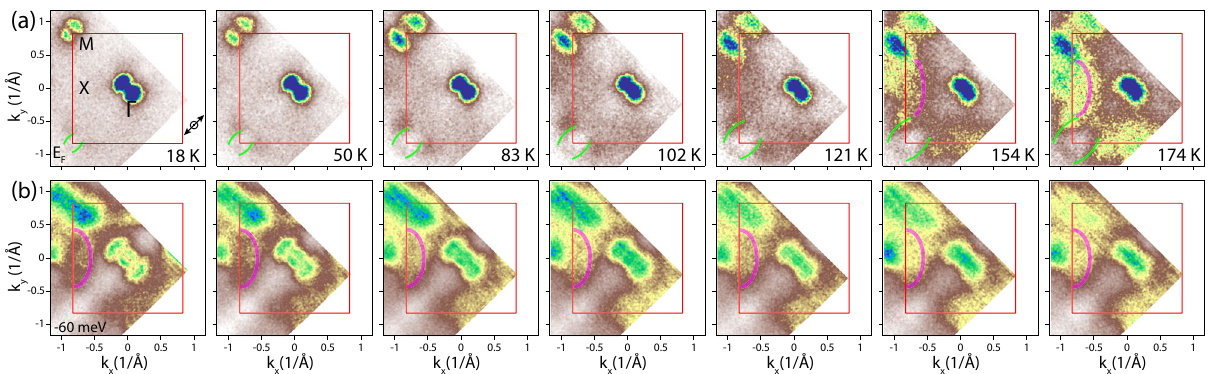
Fig. 2 Fermi surface evolution with temperature for FTS44. a Measured Fermi surfaces as temperature is varied between 18 K and 174 K. b Simultaneously measured constant energy contours at − 60 meV showing no change as a function of temperature. Polarization is as marked in the left- most panel of ( a ) indicating an in-plane polarization along Γ -M with a fi nite out-of-plane component. The red squares mark the Brillouin zone of the 2-Fe unit cell.